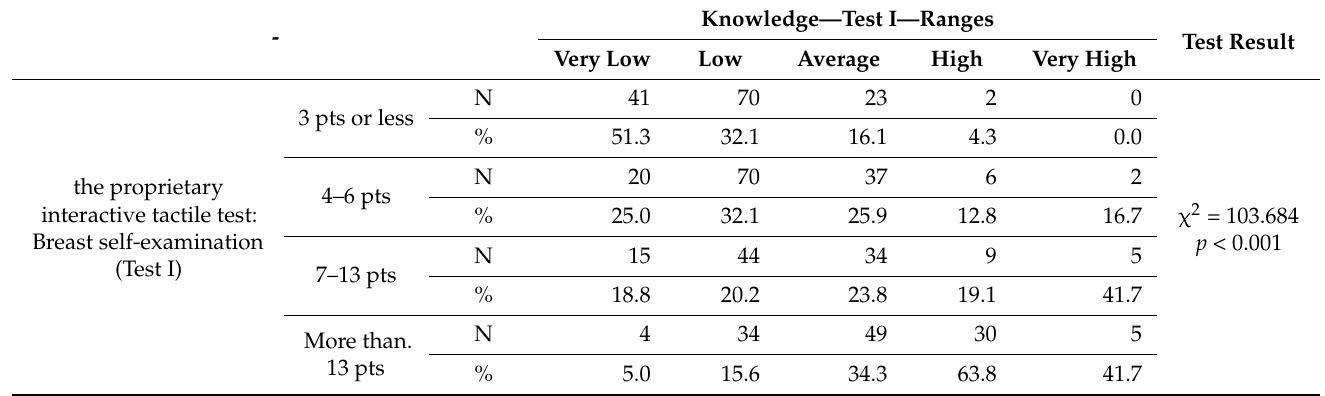
Table 11. The relationship between the level of knowledge (Test I) and the number of marked points in the tactile test (Tests I and